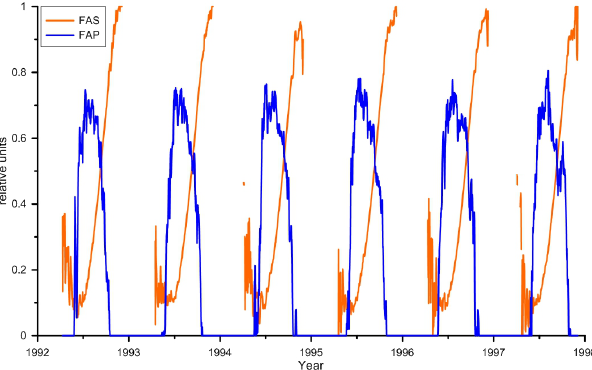
Fig. 1. Fractional vortex area covered by PSCs (FAP; blue) and frac- tional vortex area exposed to sunlight (FAS; orange) time series at 70hPa for 1992–1997.